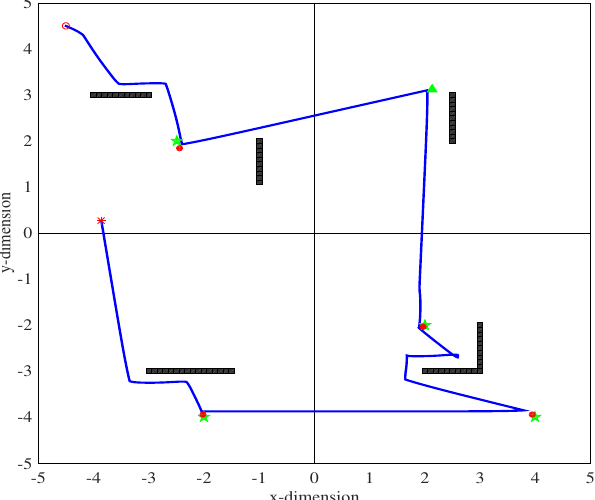
Figure 3. The robot’s movement path for Case 1.